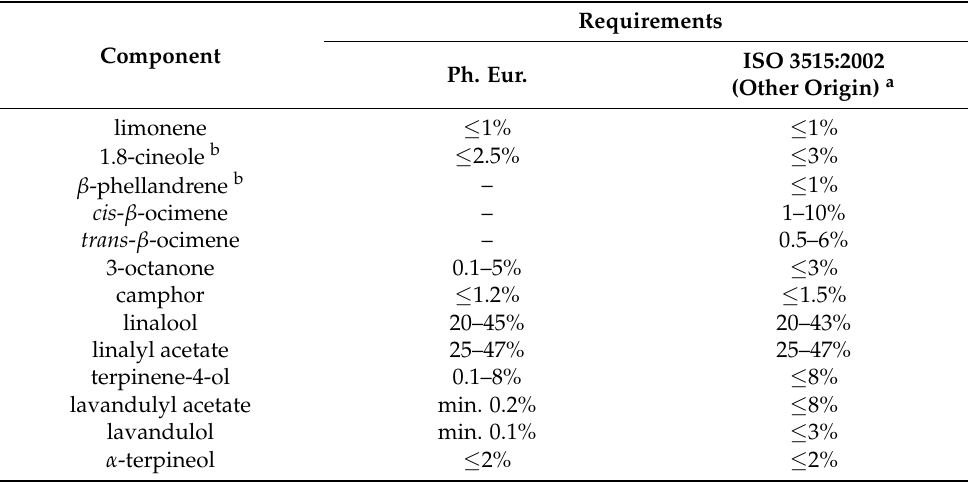
Table 4. The comparative requirements of Ph. Eur. (10th edition) and ISO 3515:2002 for the essential oil of L. angustifolia